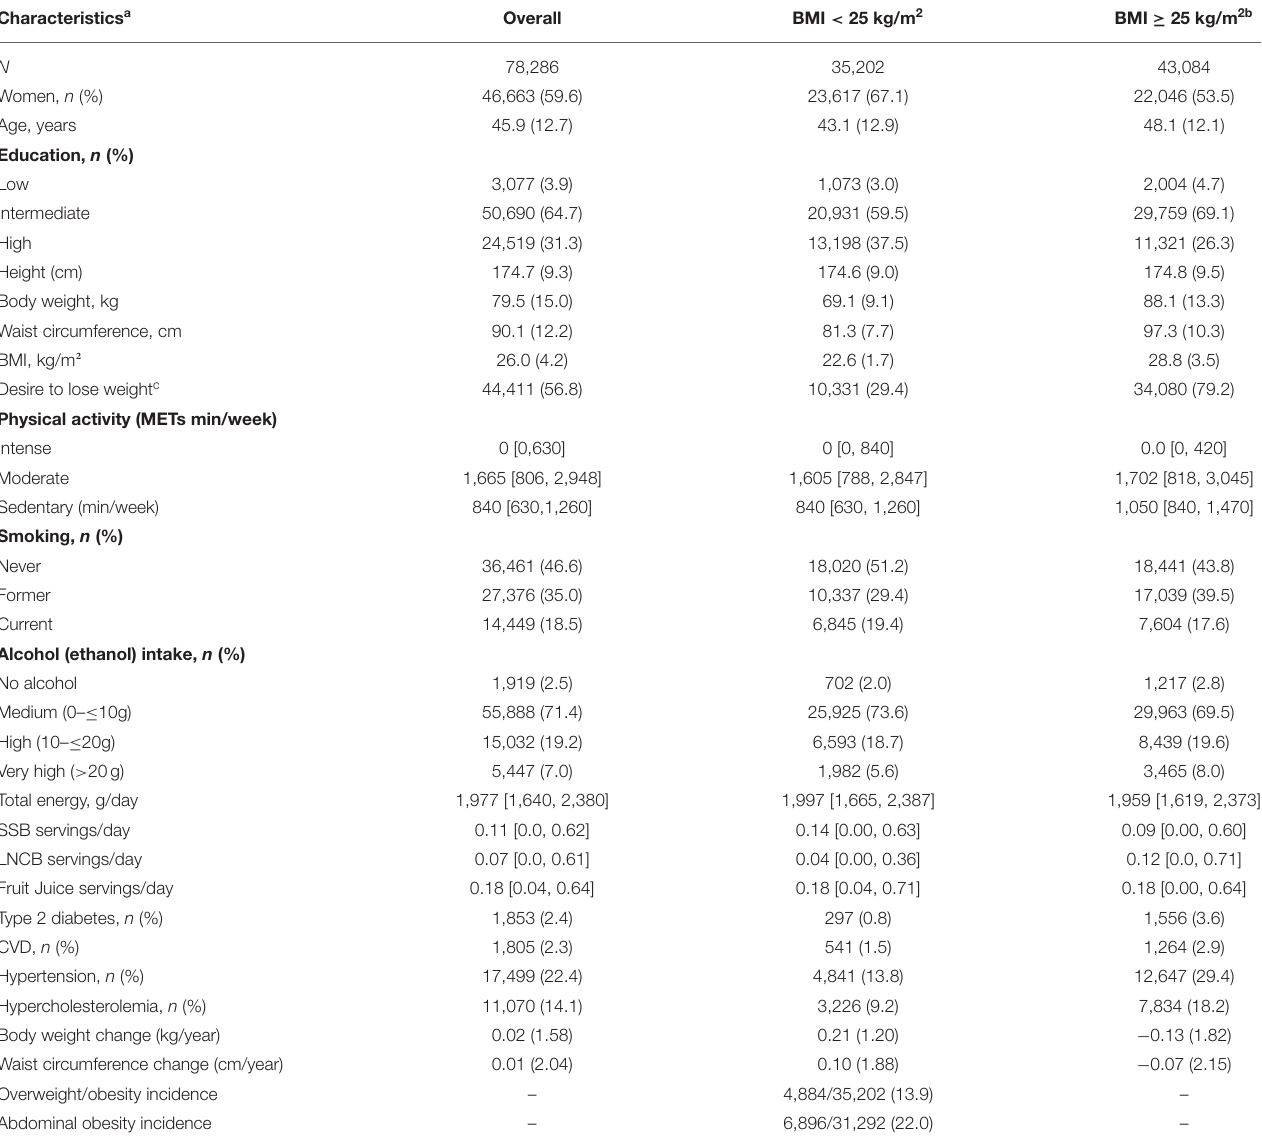
TABLE 1 | General characteristics of the Lifelines Cohort Study. Characteristics